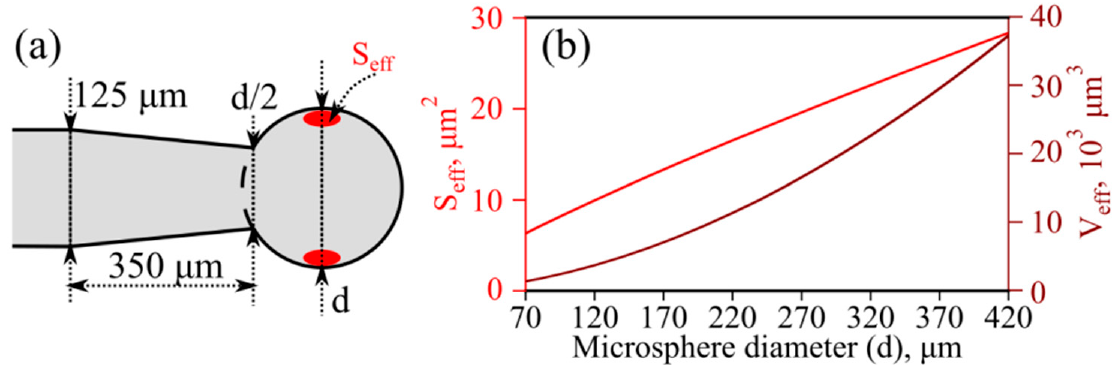
Figure 2. ( a ) Scheme of microresonator geometry used in simulations. ( b ) Effective mode area (red curve, left axis) and effective mode volume (brown curve, right axis) calculated at a wavelength of ~1.55 μ m.